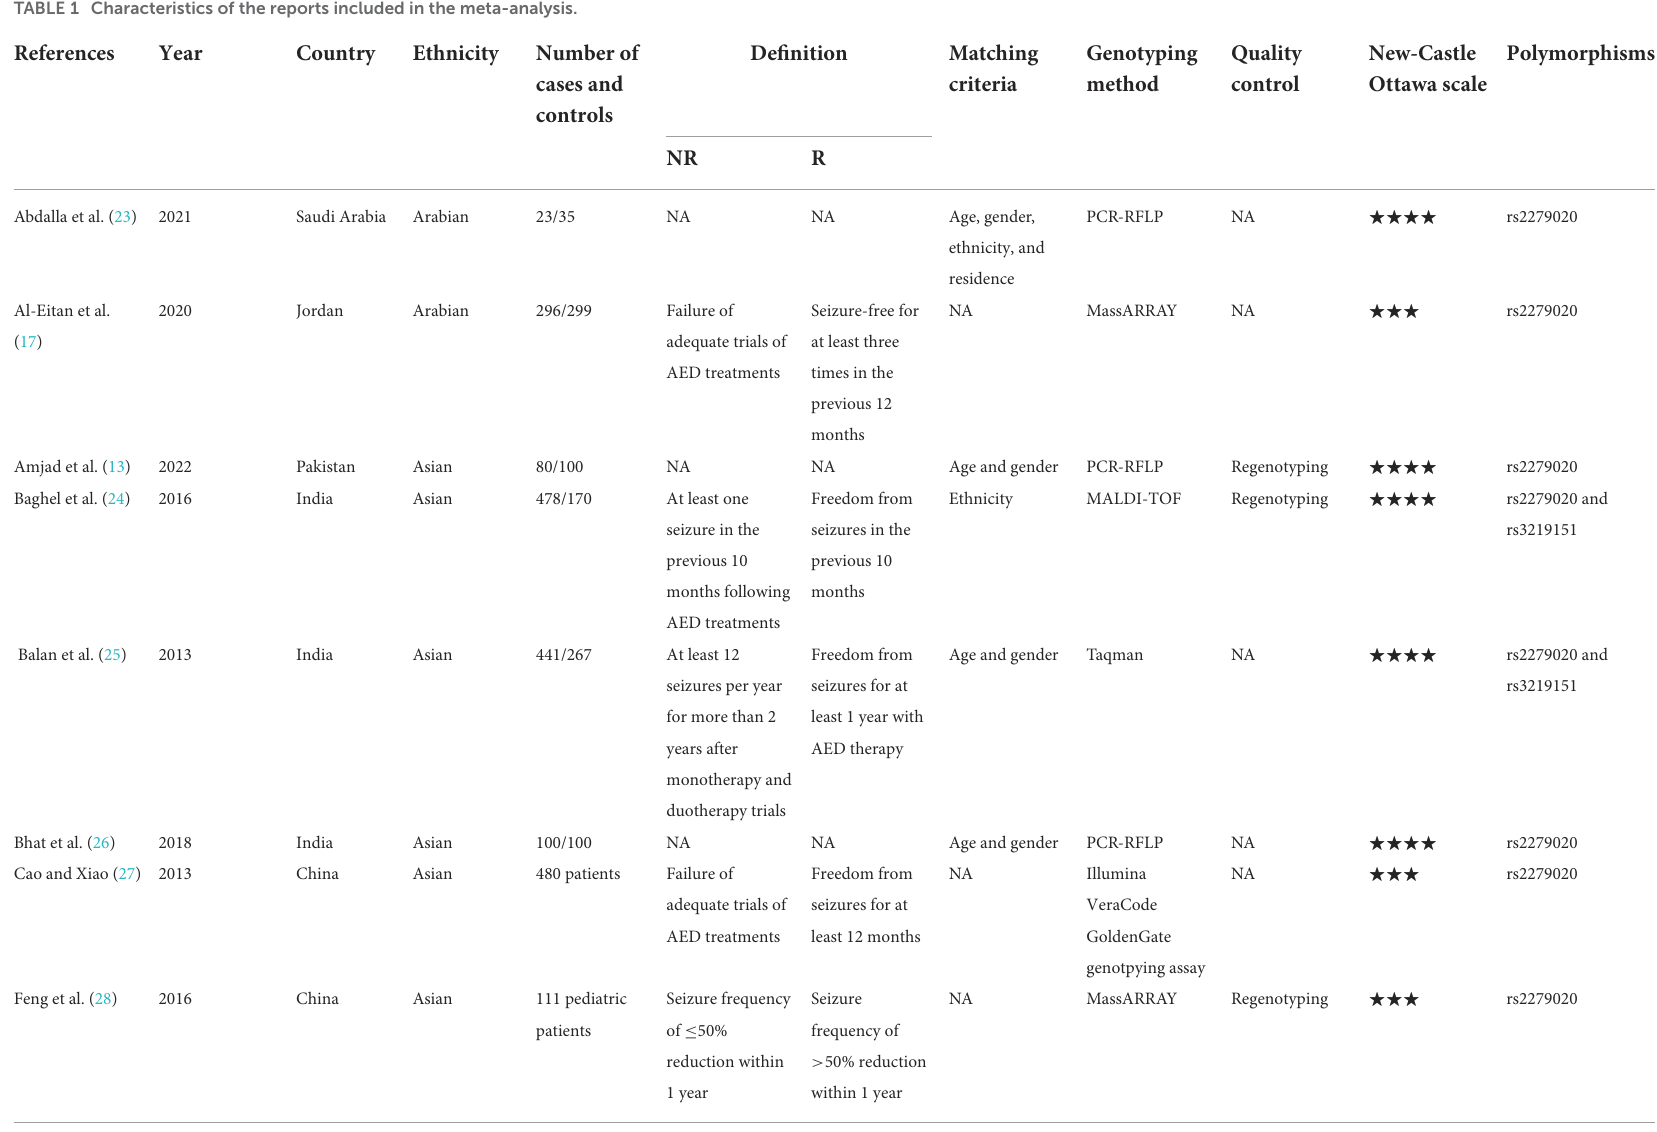
TABLE 1 Characteristics of the reports included in the